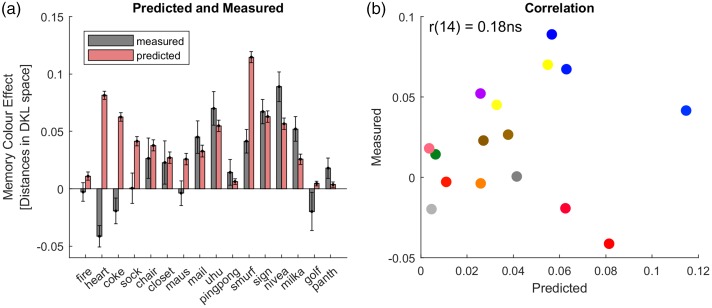
Predictions for aggregated data of Witzel et al. (2011). Panels and format are as shown in Figure 2.